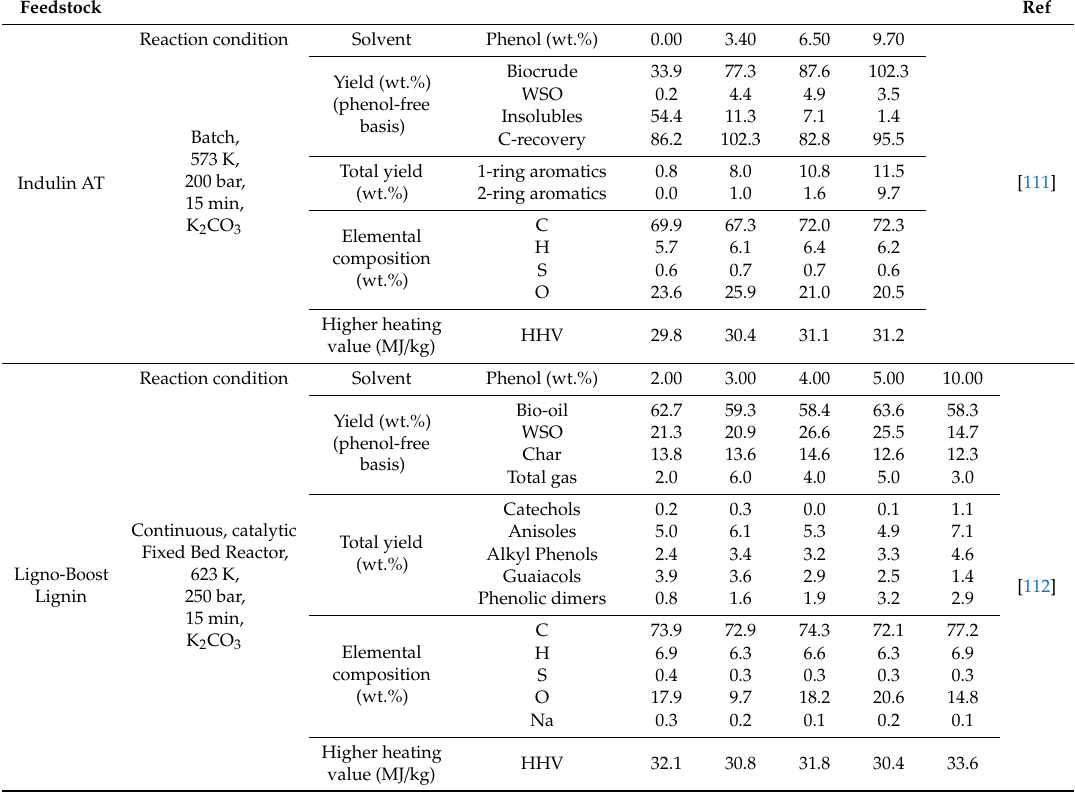
Table 10. Summary of HTL experiments with phenol as